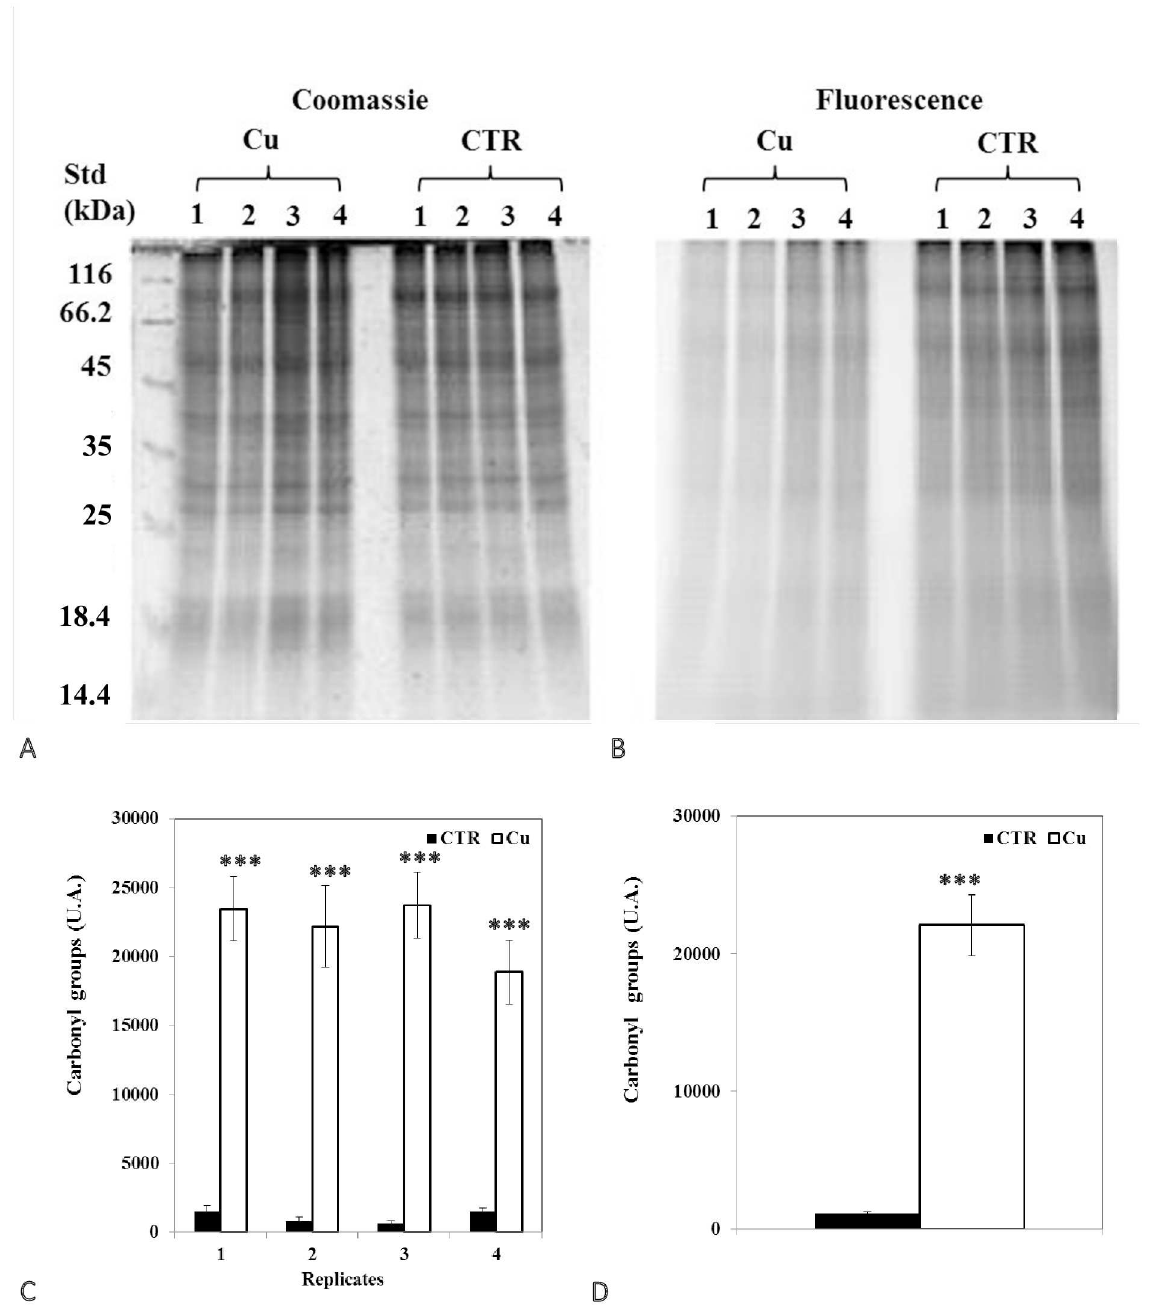
Fig 7. Representative images of 1DE gels of proteins (150 μ g) in seedlings of bean seeds germinated for 9 days in (A) the presenceof distilled water (CTR) or (B) 200 μ M Cu. Gels were stainedwith Coomassie G-250 (scannedwith GS-800 calibrated densitometer) and with FTSC labeling(scannedwith Typhoon9400 scanner). Total opticaldensitiesfor each lane obtainedfrom FTSC stainingwere normalized with those from CoomassieG-250 stainingof the same gel. (C, D) Levels of proteins containing carbonylgroups. Values shownare means of (C) 4 biologicalreplicates( ± SD) numbered from 1 to 4, and means of (D) 4 technical replicates( ± SD).Each measurement was performed in an extract obtainedfrom severalcotyledons.Analyseswere performed using ANOVA, student’s T test; * p < 0.05, *** p < 0.001.